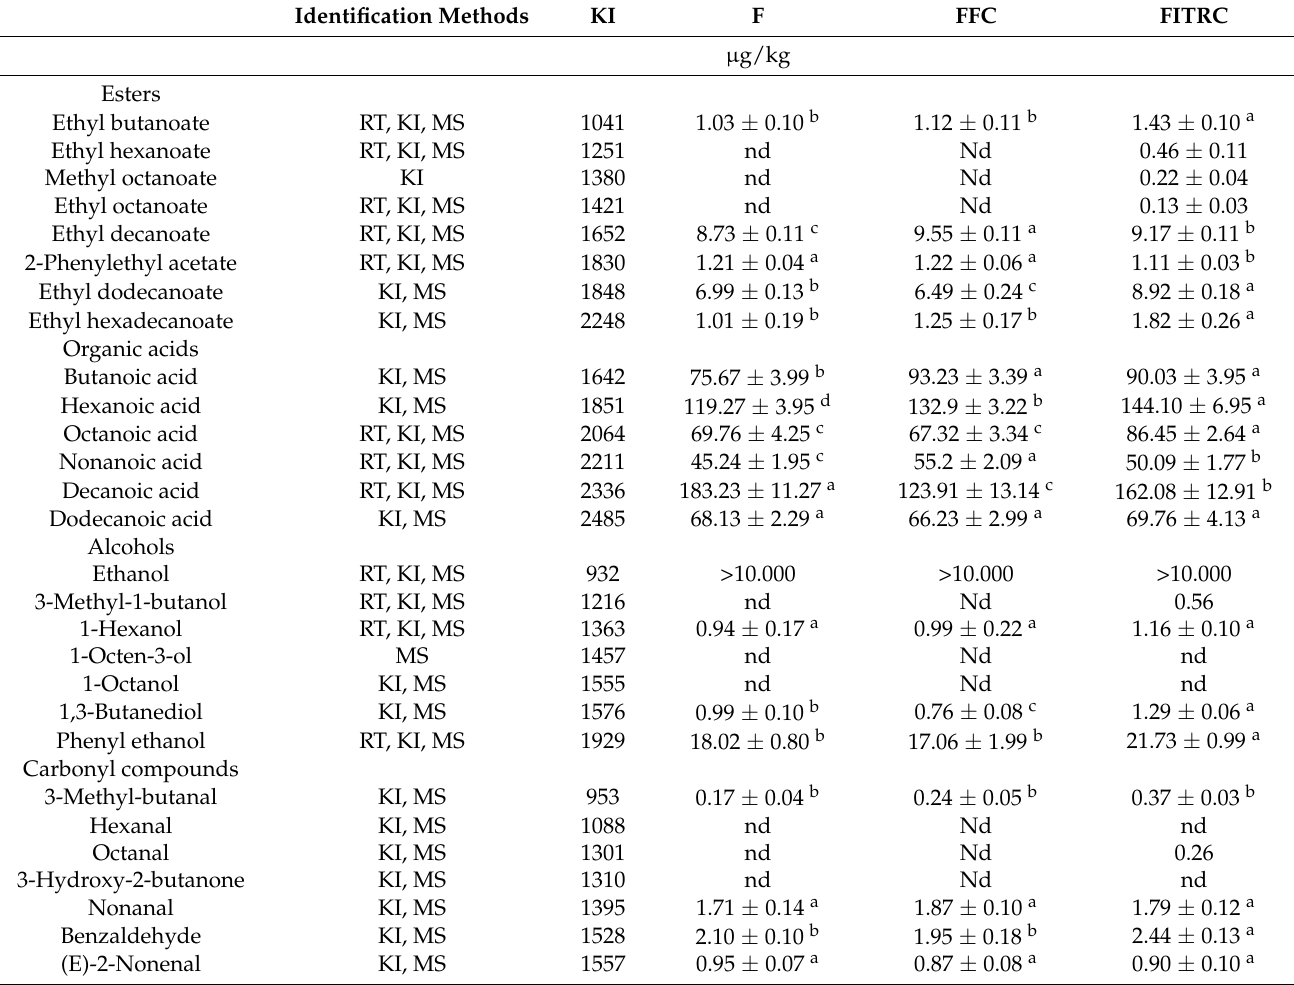
Table 3. Major aroma-related compounds ( µ g/kg of cheese) detected in white brined cheeses during refrigerated storage (70th day of storage at 4 ◦ C) by solid-phase microextraction (SPME) GC-MS